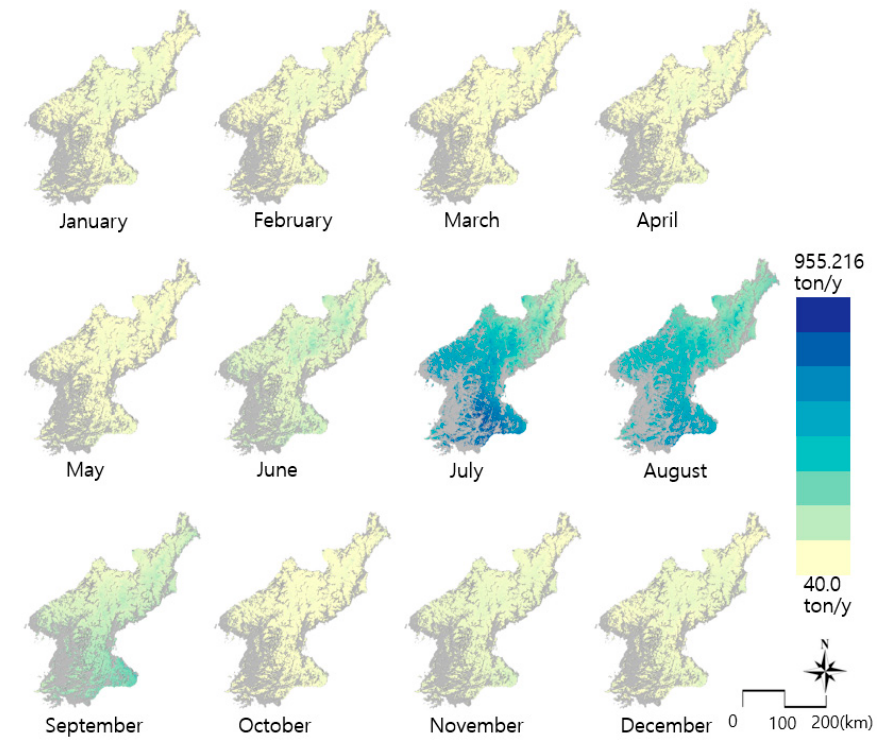
Figure 4. Monthly water yield of North Korean forests. Forests 2020 , 11 , x FOR PEER REVIEW Table 3. Water yield of North Korean forests by administrative district.